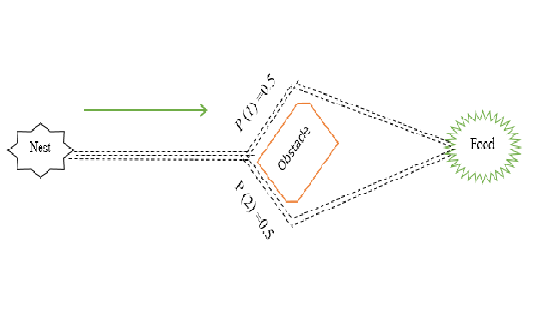
Fig. 2. Ants Obstacle